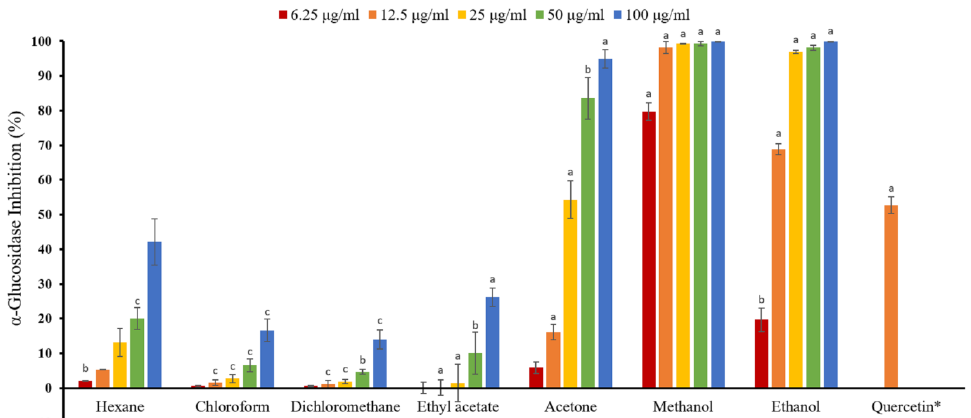
Figure 1. Bars show α-glucosidase inhibition at different concentrations of solvent extracts from M. fragran. * Quercetin (12.5 μg/mL) was used as a positive control. Bars represent mean ± SEM of three experiments. Bars marked with different letters are significantly different ( a p < 0.001; b p < 0.01; c p < 0.05 compared to control).